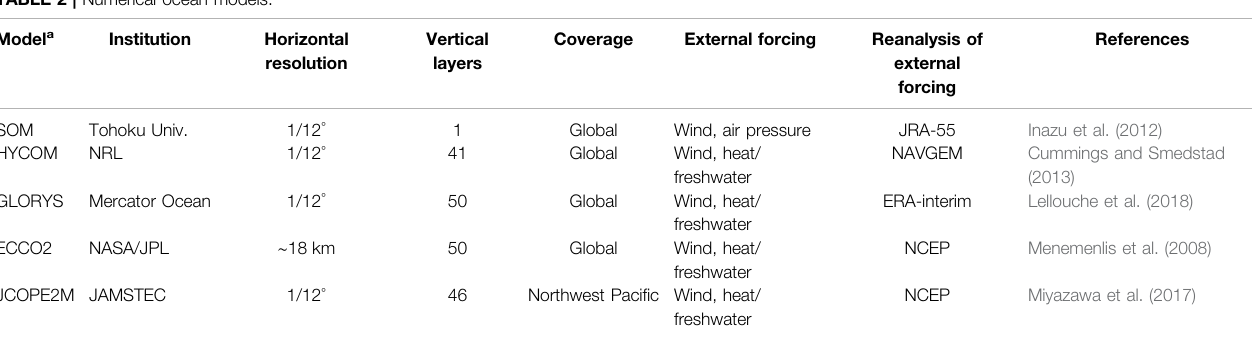
TABLE 2 | Numerical ocean